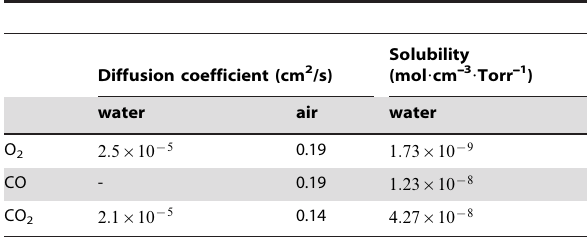
Table 3. The diffusion coefficients and solubilities of O 2 , CO, and CO 2 in water and air at 300